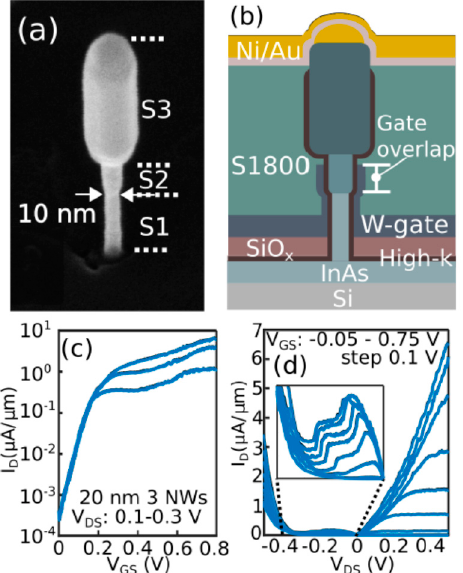
Figure 10. ( a – d ) Tunneling field-effect transistor (TFET) characterization: ( a ) SEM of a nanowire (NW) with a diameter of 10 nm when the layers are S1 = InAs, S2 = InGaAsSb, and S3 = GaSb, and ( b ) schematic of TFET structure in ( a , c ) transfer characteristics of a TFET with diameter of 20 nm, and ( d ) output characteristics of the same transistor in ( c ) [63].